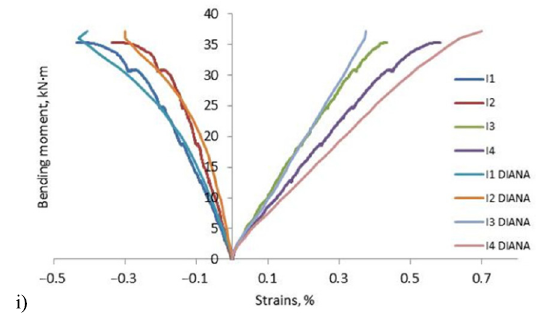
Fig. 9. Bending moment and strains curves: (i) S9 beam